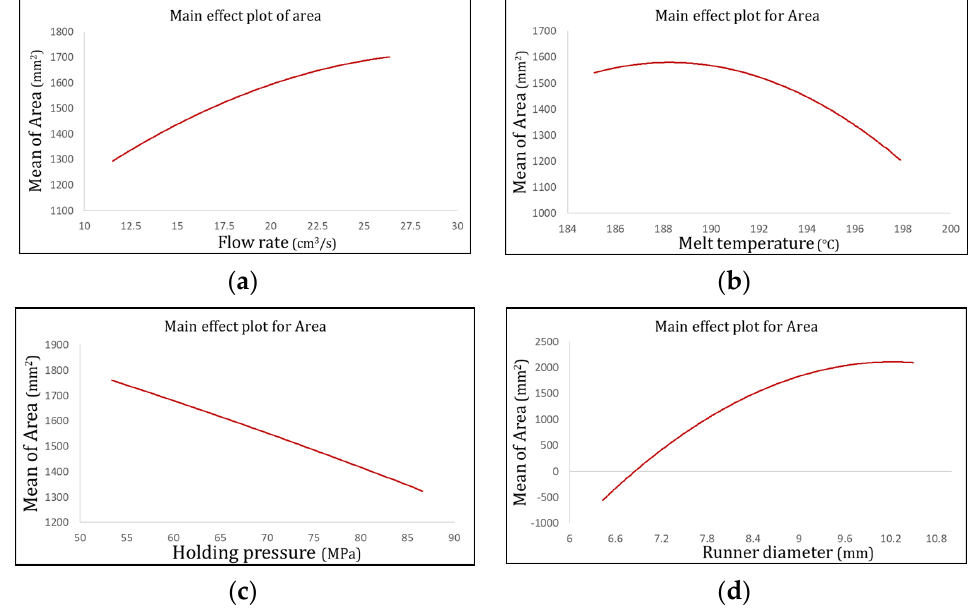
Figure 8. The effect of: ( a ) flow rate, ( b ) melt temperature, ( c ) holding pressure, and ( d ) runner diameter on the defect area.